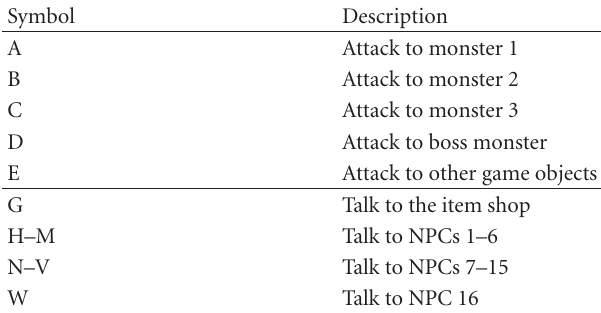
Figure 11: Map and the positions of NPCs and monsters.